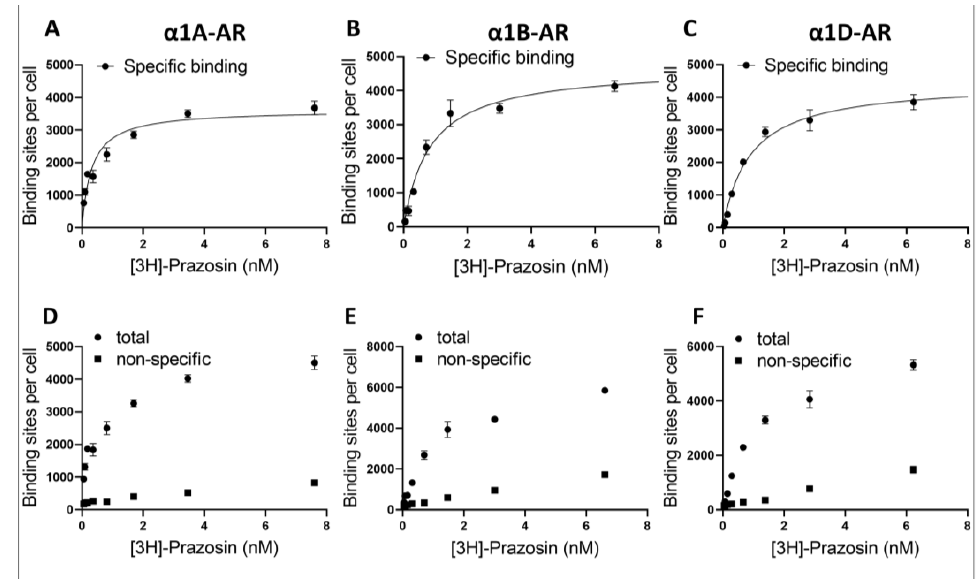
Figure 2. Saturation curves of [ 3 H]prazosin binding in the PC-12 cell lines expressing α 1A-AR ( A , D ) and α 1B-AR ( B , E ) and in the ChemiSCREEN™ Ready-to-Assay™ α 1D cells ( C , F ). Specific binding ( A – C ) was determined by subtracting the amount bound in the presence of 10 μM prazosin for [ 3 H]prazosin from the total radioactivity bound per milligram protein ( D – F ). Each point represents the mean ± SEM of quadruplicate determinations from four experiments.